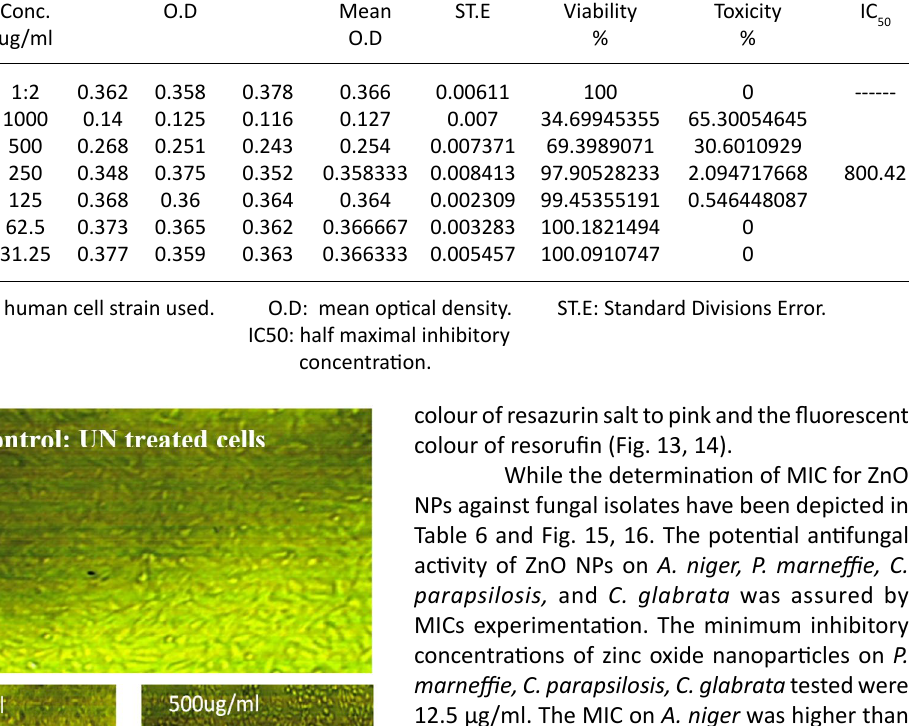
Table 7. Effect of ZnONPs on wi38 cells at different concentrations ID Conc. O.D